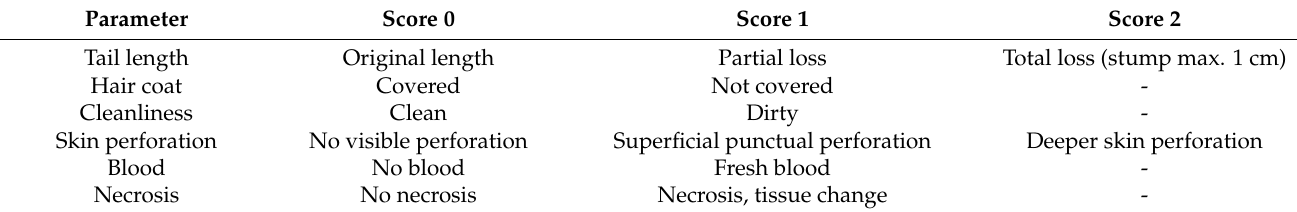
Table 3. Scoring scheme for possible tail lesions (German pig scoring system (Deutscher Schweine Bonitur Schlüssel) of FLI [44],